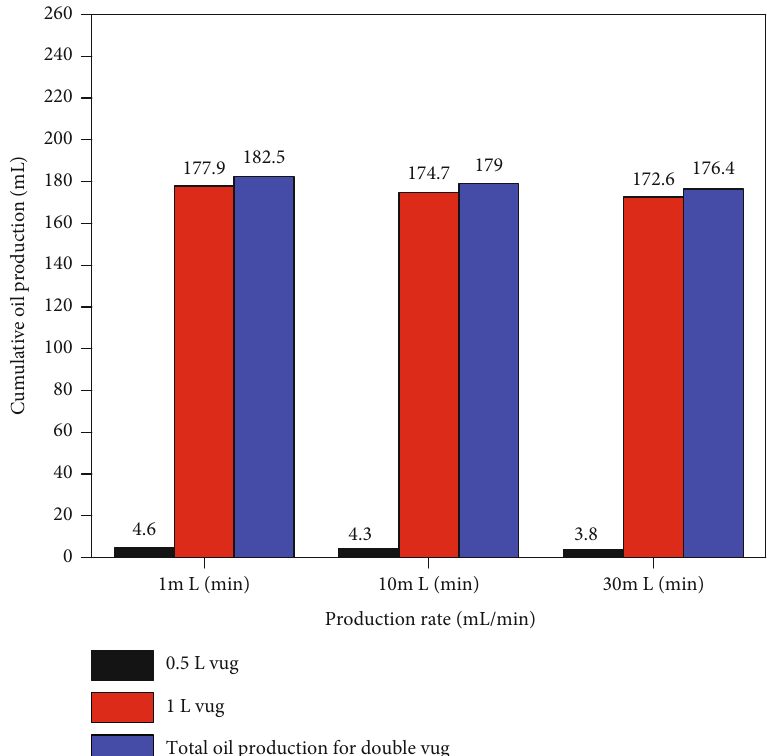
Figure 4: Column chart of cumulative oil production in high-pressure physical property experiments under connection type I (di ff erent production rates).